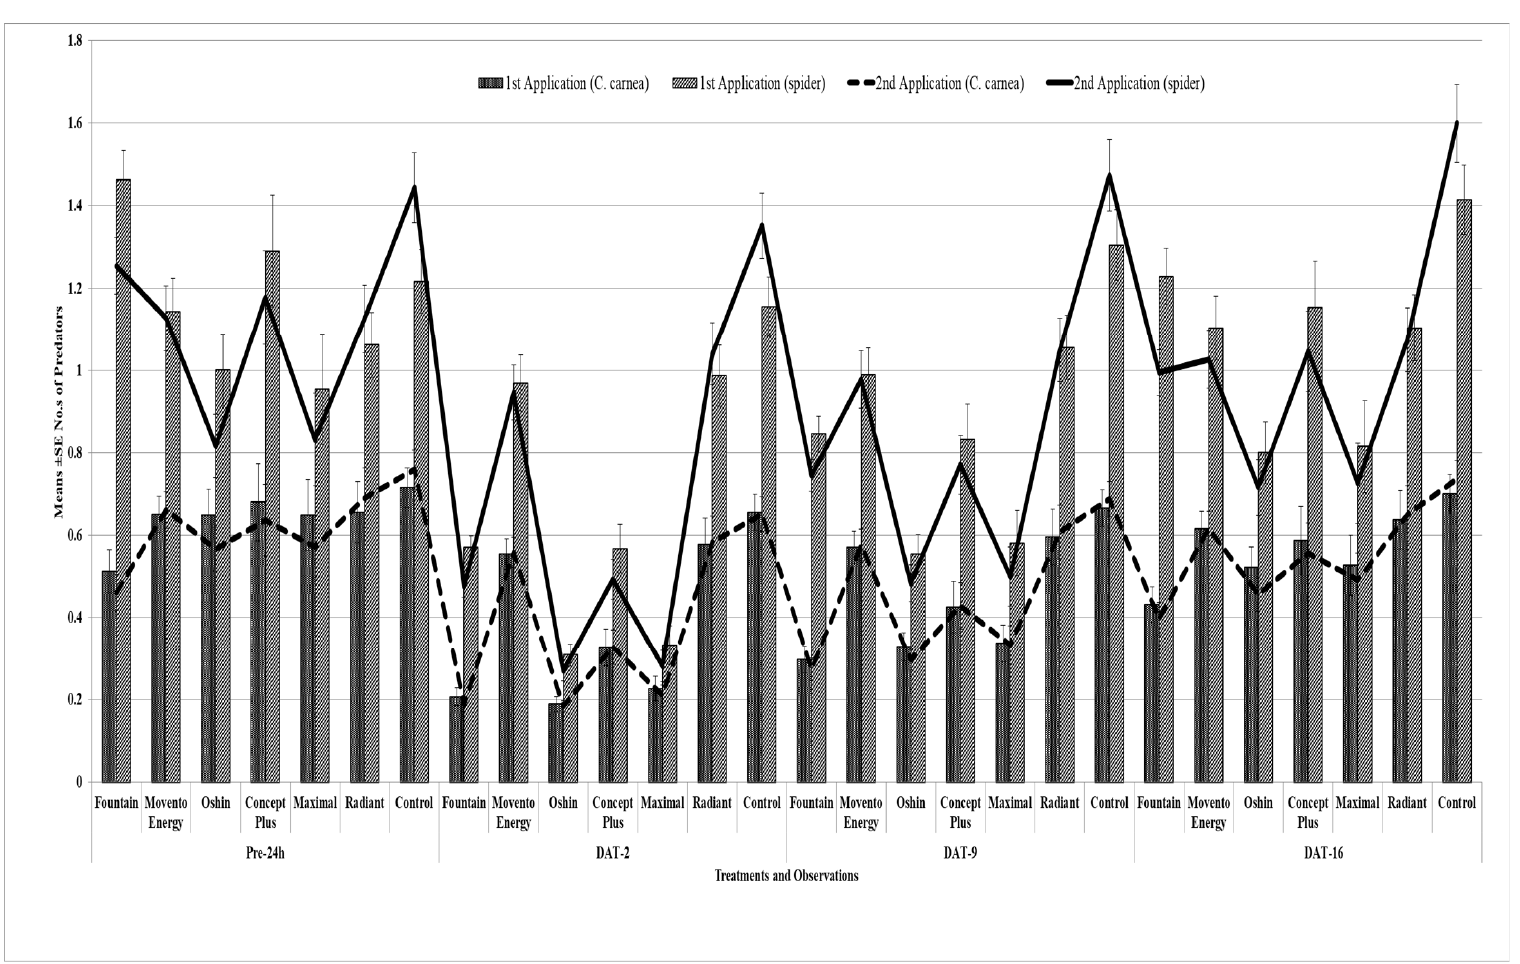
Figure 1. Effect of different insecticides on numbers of C. carnea and predatory spiders per plant. Mean (±SEM) in Bt cotton field plots on 1 July 2018 and 20 July 2018, observed at pre-24 h, 2 DAT, 9 DAT, and 16 DAT (days after treatment).